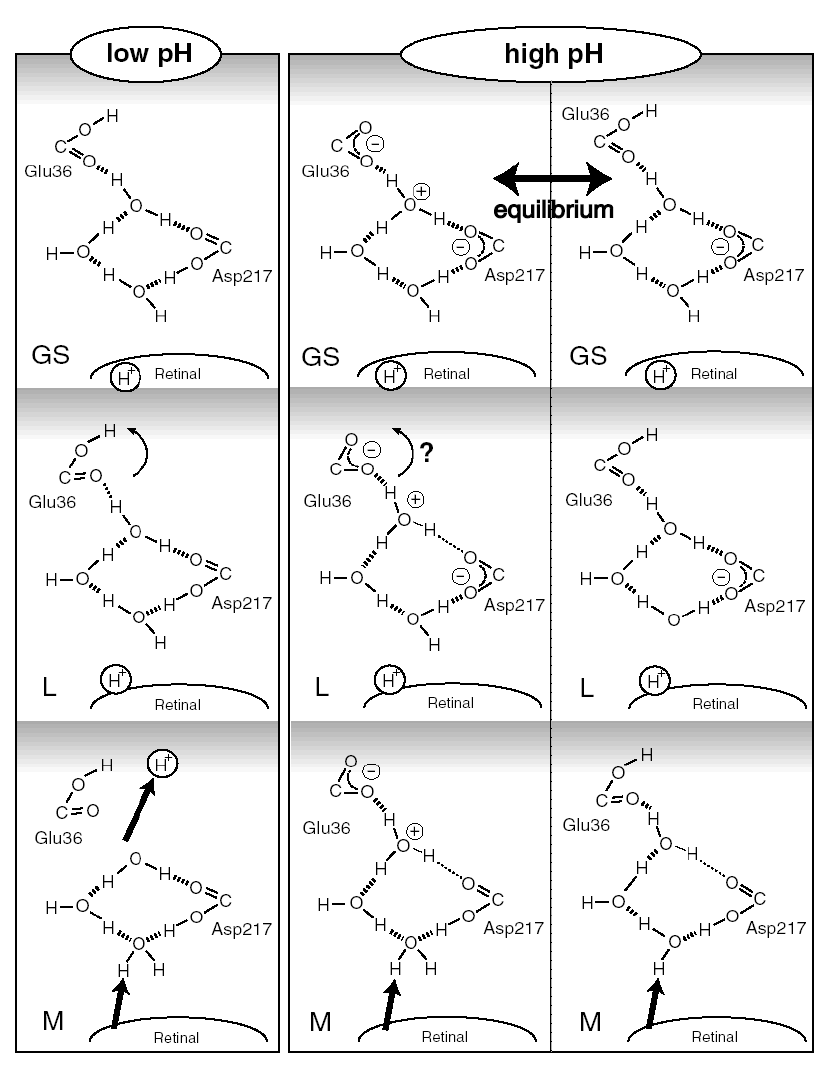
Figure 38. Possible models of hydrogen-bonding alterations in the cytoplasmic region of ASR (see text for